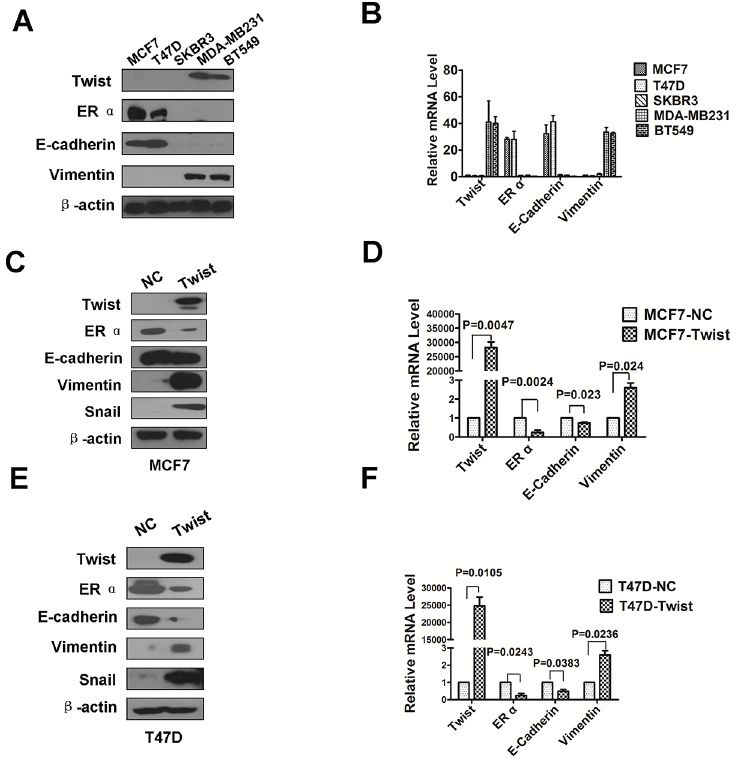
Fig 1. Twist promotes epithelial-mesenchymal transition (EMT) markers. (A) Expression of Twist, ER α , E- cadherin and Vimentin in breast cancer cell lines was analyzed by Western blotting. β -actin was used as a loading control. (B) The transcriptional level of Twist, ER α , E-cadherin and Vimentin were detected by Real- Time PCR analysis. All the data were collected from three independent experiments. (C and E) Overexpression of Twist resulted in a loss of E-cadherin and a gain of Vimentin and Snail in MCF-7 and T47D cells. The expression of ER α , E-cadherin, Vimentin and Snail was detected by western blot analysis. β -actin was used as the loading control. (D and F) Overexpression of Twist resulted in a decrease of E-cadherin and an increase of Vimentin and Snail in mRNA level in MCF-7 and T47D cells. The mRNA expression levels for each target gene were subsequently normalized by the mRNA level of β -actin. All samples were measured in triplicate and P value low than 0.05 for MCF-7 and T47D cells overexpressing Twist compared with the corresponding MCF-7 and T47D cells transfected with empty vector. Data shown are means ± SD of at least three independent experiments. P -values were obtained using the Student ’ s t -test analysis. Western blot was used to detected Twist and EMT marker expression (n =